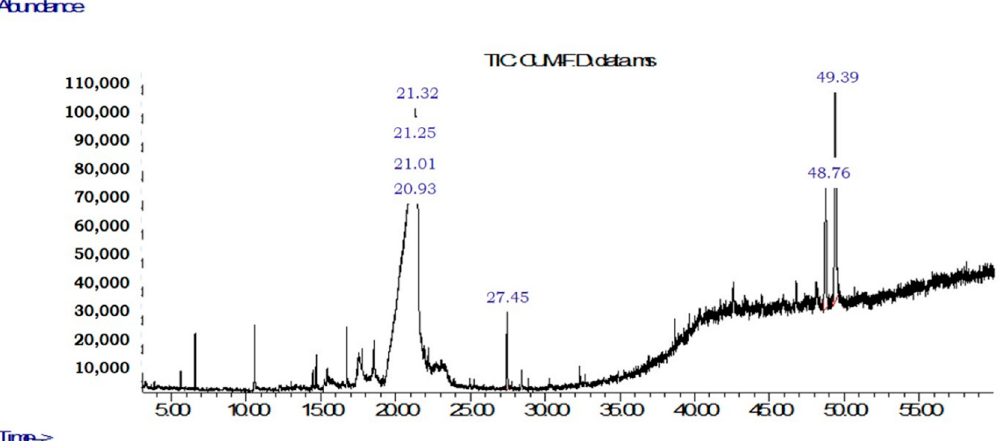
Figure A1. Dipteryx odorata leaves extract chromatogram.